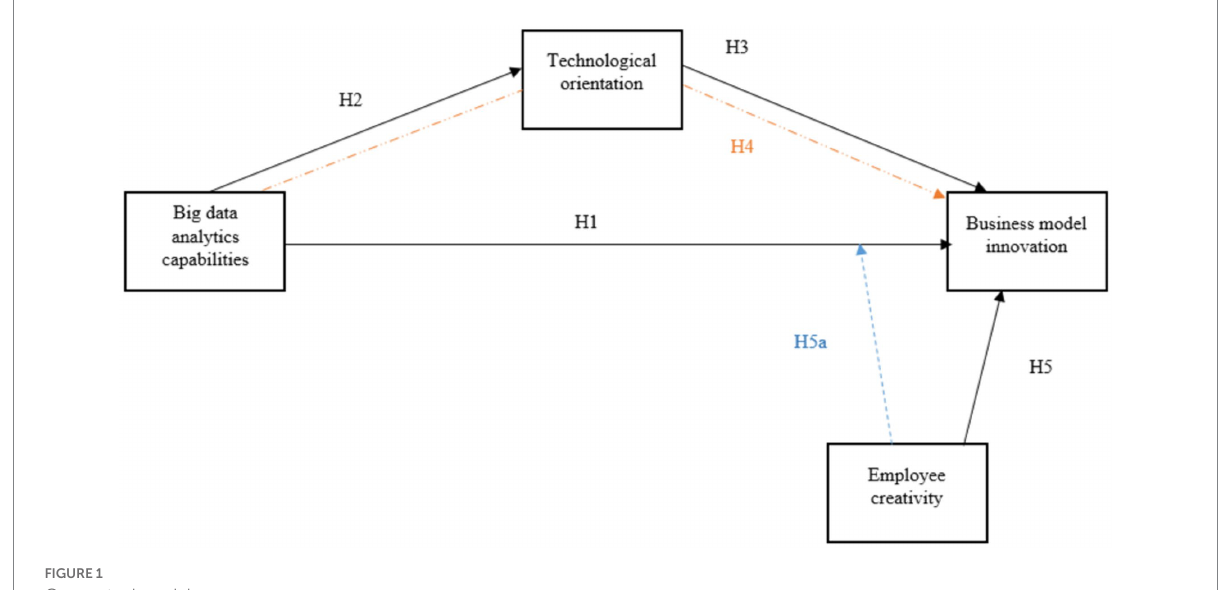
FIGURE 1 Conceptual model.